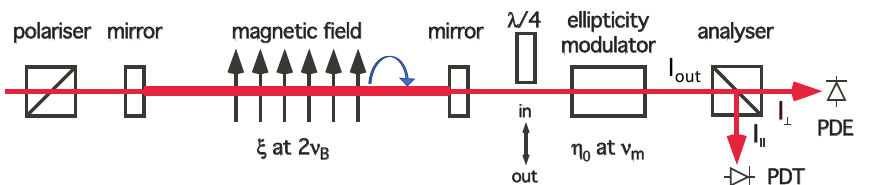
Figure 5. Schematic drawing of the PVLAS polarimeter. A rotating magnetic field between the cavity mirrors generates a time-dependent ellipticity. The laser frequency is phase-locked to the cavity resonance; the locking system (not shown in figure) uses the power reflected from the cavity exiting the input polarizer along the input